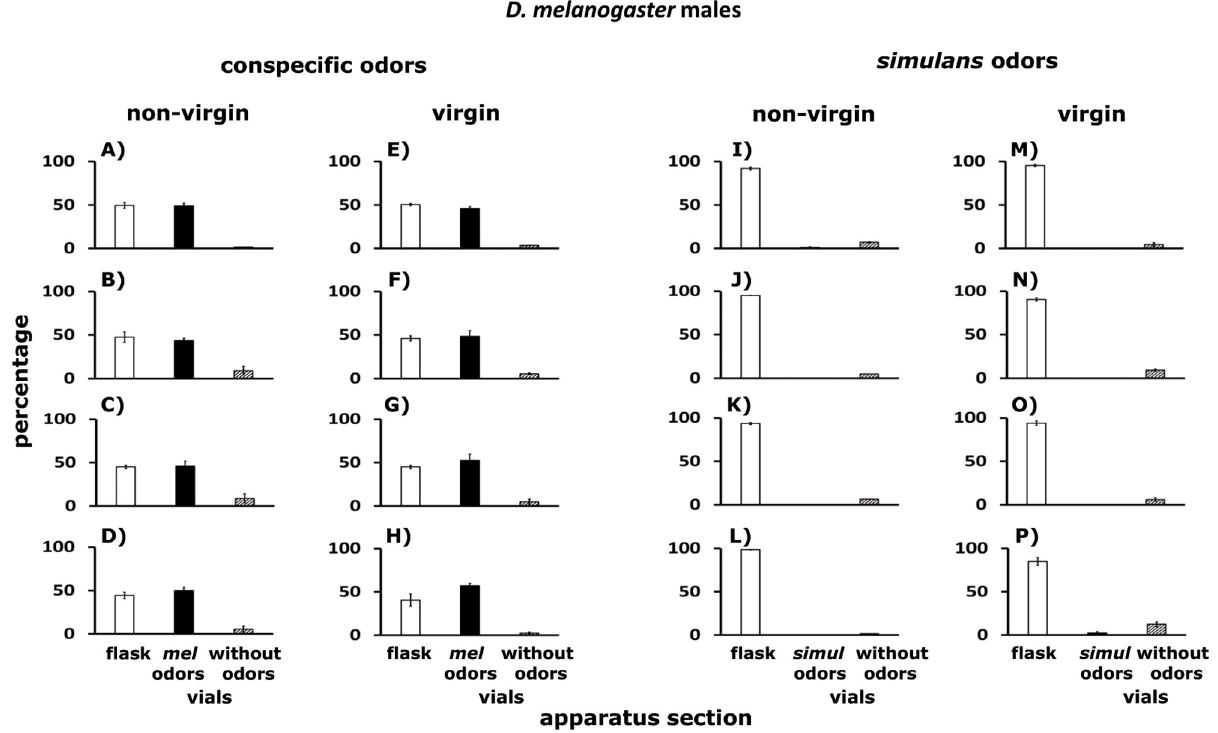
Fig 11. A–P. Dispersal of D . melanogaster males confronted with odors of conspecifics, and odors of D . simulans . Males tested were non-virgin (A– D and I–L) and virgin (E–H and M–P). White columns indicate percentages of flies that remained in the flask. Black columns stand for percentages of flies found in the Y-tubes connected to vials with conspecific (or D . simulans ) odorants. Hatched columns show percentages of flies in the Y-tubes connected to empty vials. Conspecific odorants came from: (i) non-virgin males (A, E), (ii) virgin males (B, F), (iii) non-virgin females (C, G), (iv) virgin females (D, H). D . simulans odorants were emitted by: (i) non-virgin males (I, M), (ii) virgin males (J, N), (iii) non-virgin females (K, O), (iv) virgin females (L, P). See Fig